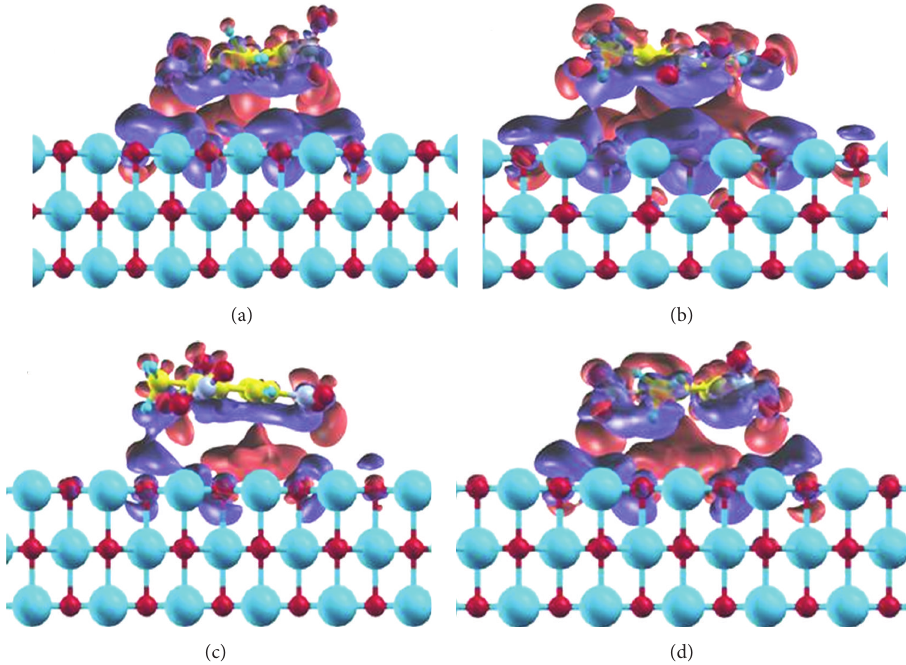
F 4: Electronic charge density of the systems adsorbed on the MgO surface with three layers, the uppermost fully relaxed. (a) Side view of Position 1; (b) side view of Position 2; (c) side view of Position 3; (d) side view of Position 4. Blue color indicates regions of charge accumulation while red ones indicate charge